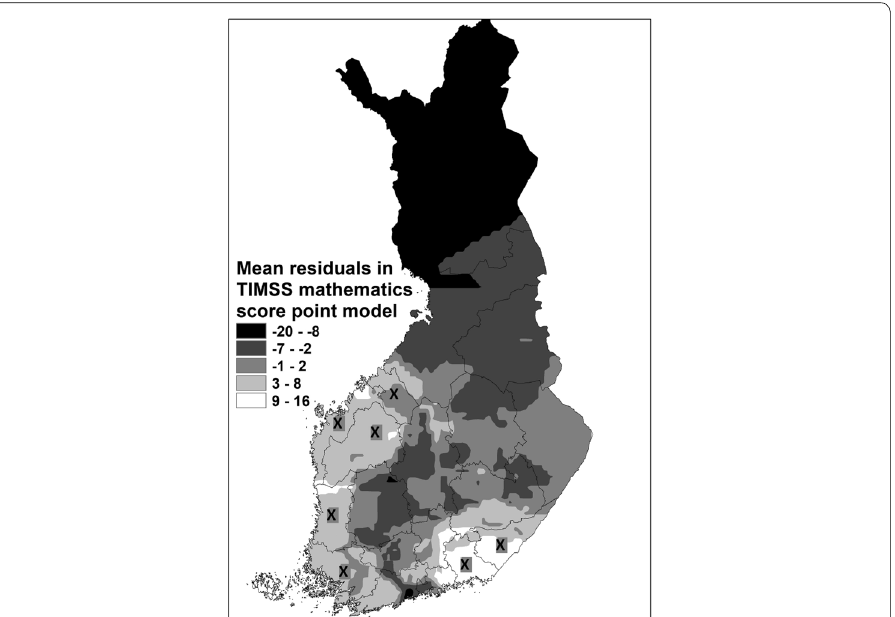
Fig. 2 Mean residuals in TIMSS 2015 fourth‑graders’ mathematics score point model. In the areas where the residual is low, the students scored lower than what the model predicts. In the high residual areas students performed better than what the model predicts. This indicates that family‑related indices do not have an invariable or static effect